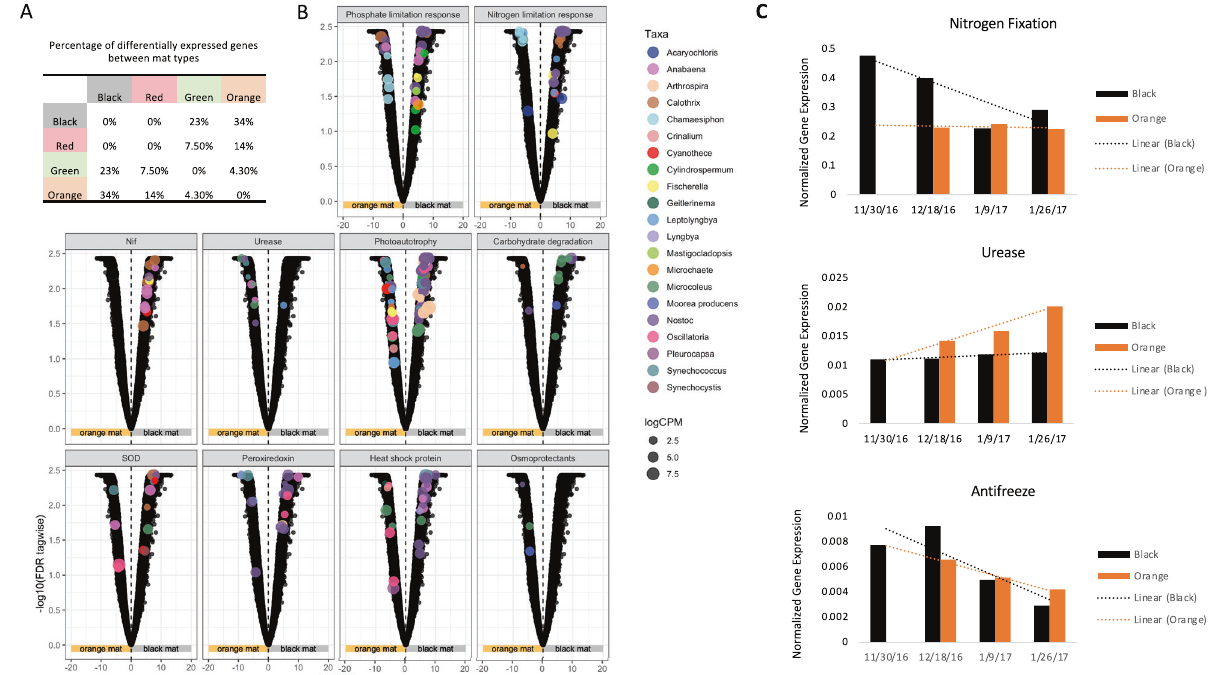
Fig. 5 Differential Expression Analyses. A Venn diagram showing the percentage of signi fi cantly differentially expressed ORFs between mat types. B Differential expression of ORFs between orange and black mat pseudo replicates (12/18/16, 1/9/17 and 1/28/17). The following facet labels represent the collection of pathway-critical genes, referenced in Chan et al. [85] to depict functional processes: Nutrient limitation: “ Phosphate limitation response ” , “ Nitrogen limitation response ” . The following genes were used for detection of phosphate limitation: Alkaline phosphatase response regulators, high af fi nity phosphate-speci fi c ABC transport genes, phoA, phoB, pstSCAB. For nitrogen limitation the following genes were used: glutamine synthase and regulators glnA, glnR, tnrA. Nitrogen cycling: Nitrogen fi xation “ Nif ” , “ Urease ” . Carbon cycling “ Photoautotrophy ” , “ Carbohydrate degradation ” . Stress responses: Superoxide Dismutase “ SOD ” , “ Peroxiredoxin ” , “ Heat shock protein ” and “ Osmoprotectants ” . Signi fi cantly differentially expressed ORFs are colored by taxonomy and scaled by abundance. C Library-normalized expression of (top) nitrogen fi xation, (middle) urease, and (bottom) antifreeze ORFs from black and orange mats over time. This analysis highlights the expression of several individual genes over at the single time point level. Additionally no orange mats were present in the streams at the November time